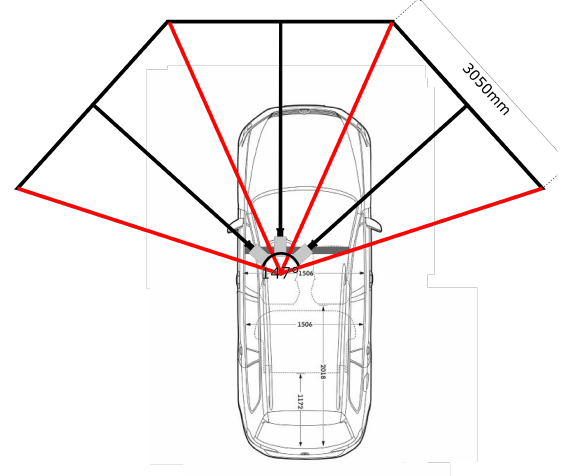
Figure 5: The three screens are aligned at an angle of 151° to each other. The distance to the driver in the center is about 3,75m. Each screen has a size of 3.05m x 1.89m, which leads in a coverage of the field of view of 147° x 39° (compare figure 7).